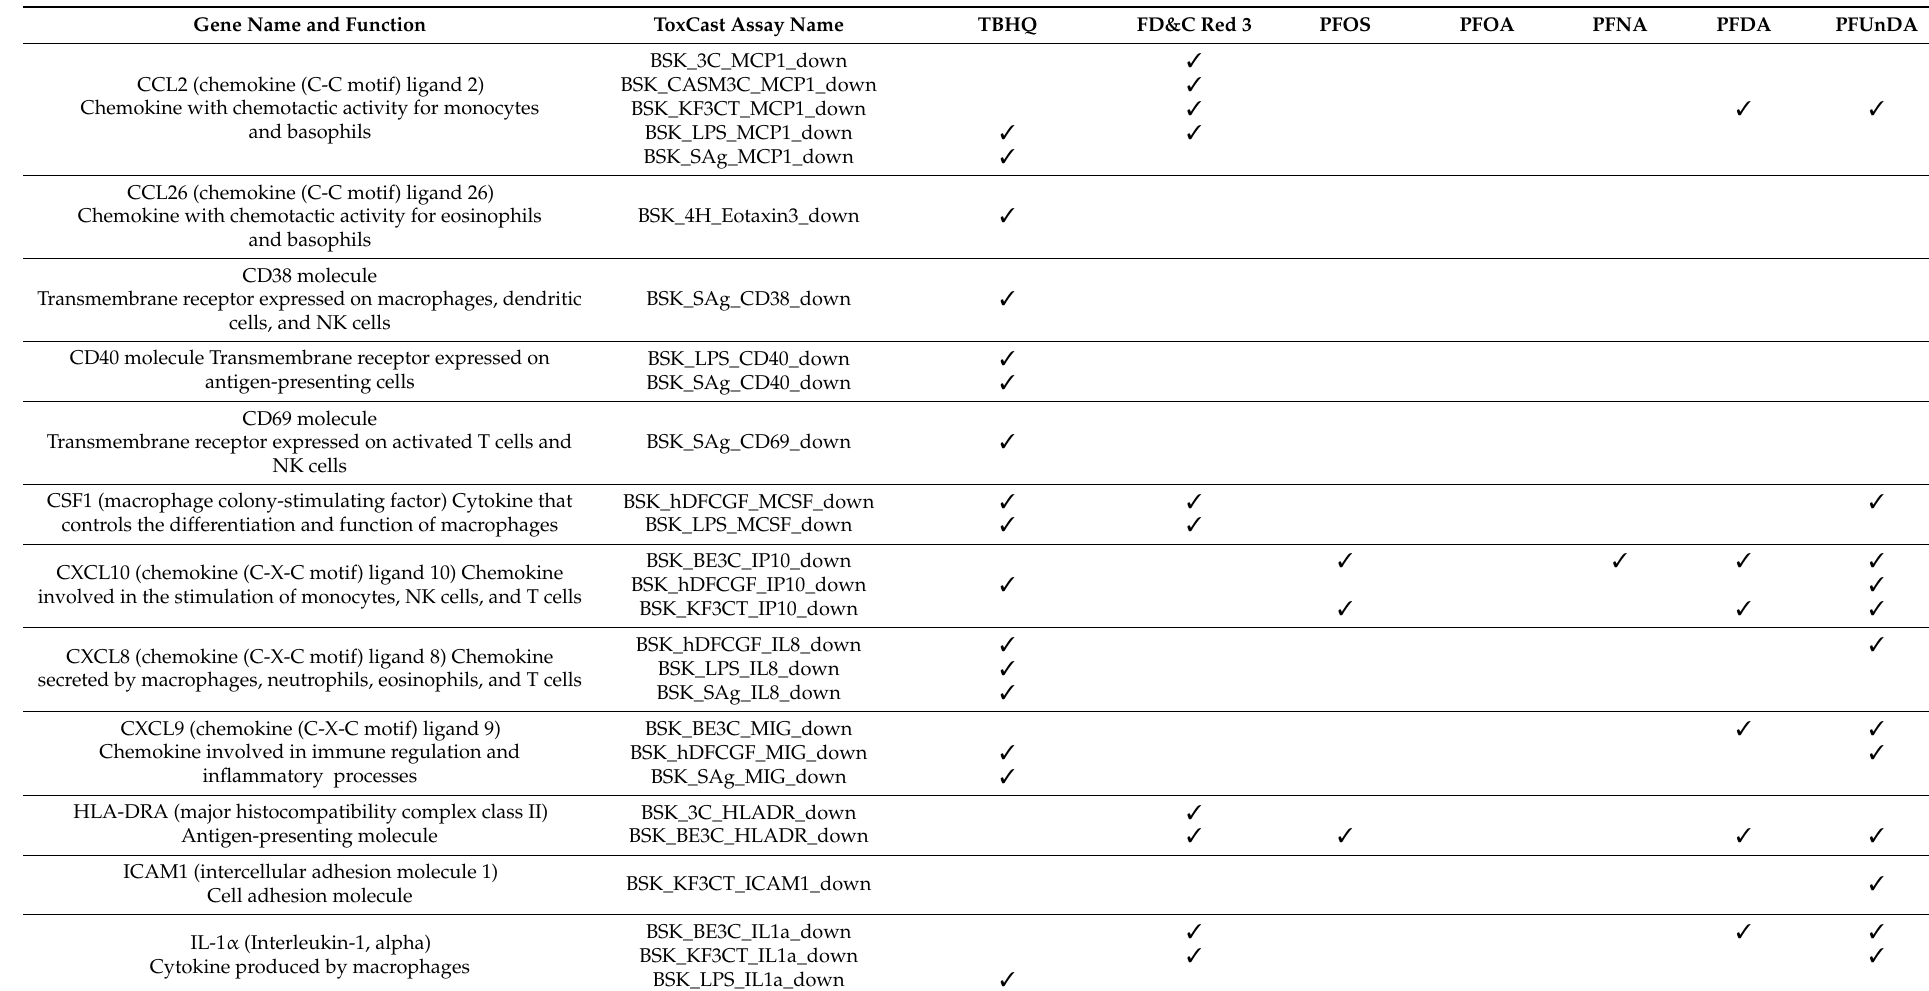
Table 3. Immune targets in ToxCast assays affected by tert-butylhydroquinone, FD&C Red 3, and several per- and polyfluoroalkyl substances. Gene Name and